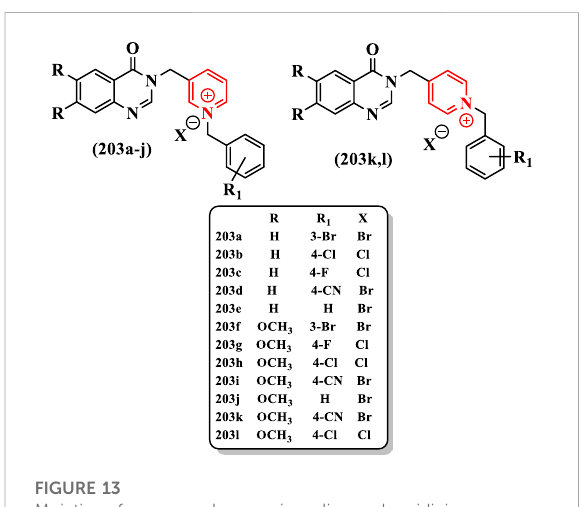
FIGURE 14 Isoindoline-1,3-dione – N-benzylpyridinium hybrid